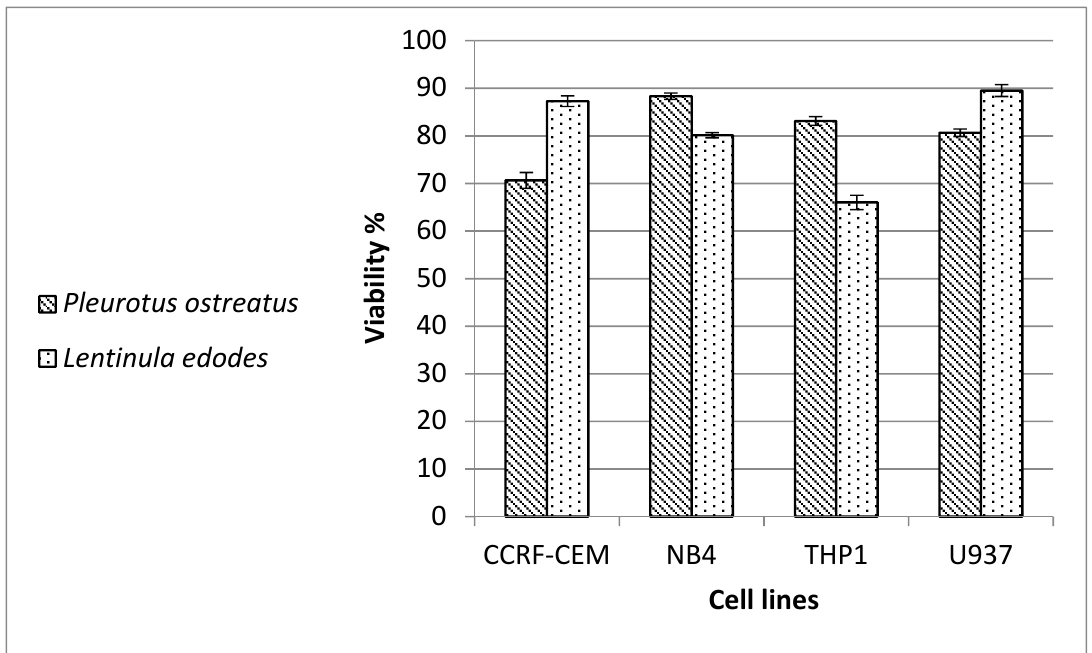
Figure 3. Cell viability of leukemic cells (CCRF-CEM, NB4 and THP1) and lymphoma U937 after treatment with Pleurotus ostreatus and Lentinula edodes extracts.